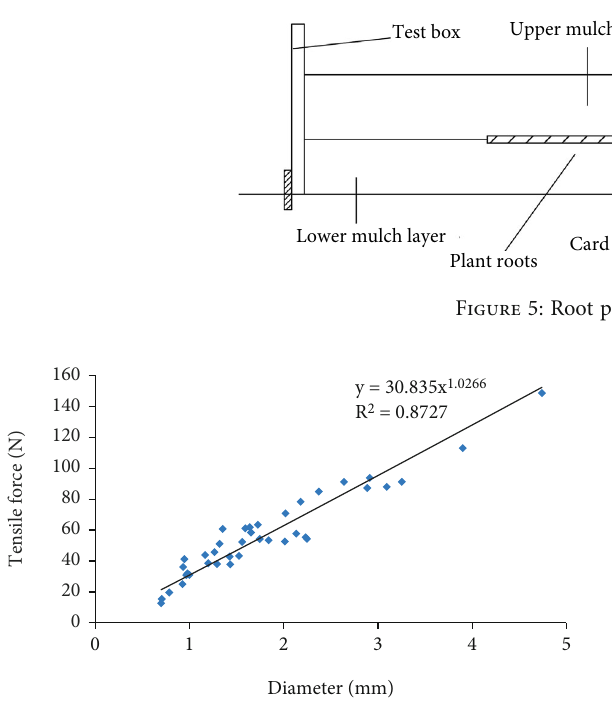
Figure 4: Composite tailing soil samples of tailing soil and A. fruticosa root soil prepared.